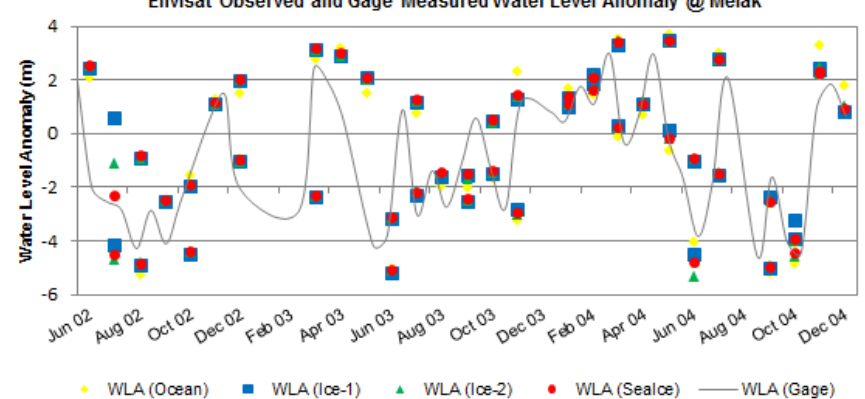
Figure 6. Water level anomaly at Melak as observed by two Envisat passes and retracked by four retrackers, compared with the in situ water level anomaly.